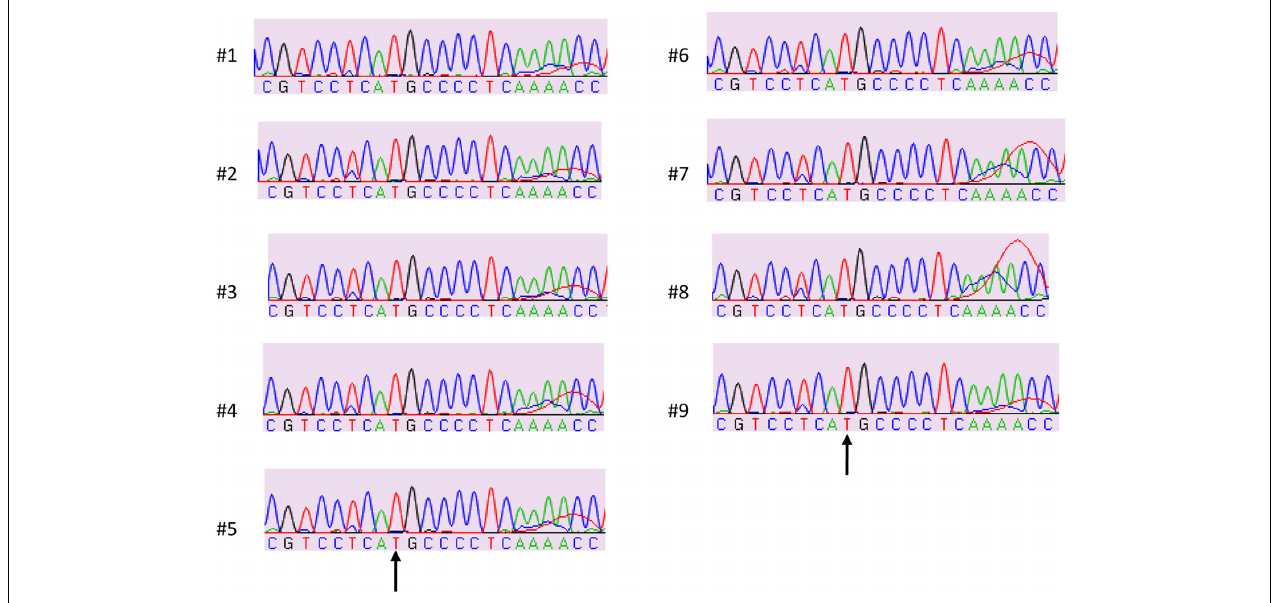
FIGURE 3 | Sample sequences of TNF − 308 SNP on Nco I digested fragment (3 (cid:2) strand). “T” nucleotide on the 3 (cid:2) strand represents the TNF − 308 “A” allele on 5 (cid:2)